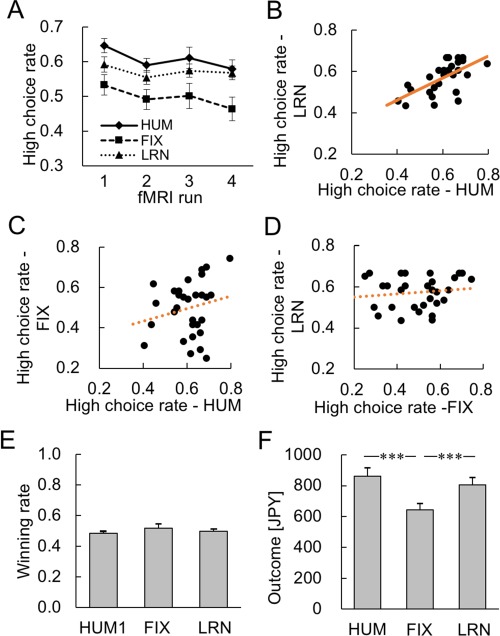
Behavioral results. (A) Percentage of high choices in four fMRI runs. The participants significantly reduced their high choice rates over time. A planned contrast between HUM-LRN combined and FIX was also significant. (B) Significant correlation of high choice rates between HUM and LRN conditions (r = 0.60, P < 0.001). (C) No significant correlation of High choice rates between HUM and FIX conditions (r = 0.20, P = 0.28). (D) No significant correlation of high choice rates between FIX and LRN conditions (r = 0.13, P = 0.49). (E) No significant difference in winning rates among the opponent types. (F) Monetary outcomes in each opponent condition. The outcomes in HUM and LRN conditions (not distinguishable from each other) were significantly higher than that in FIX condition. The asterisks indicate statistical significance (***P < 0.001).